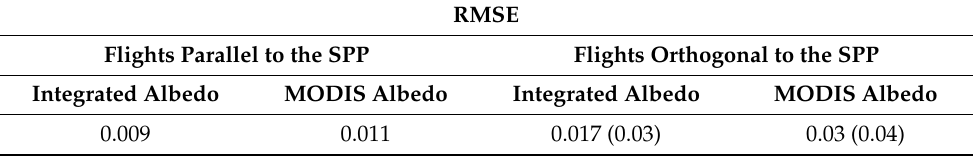
Figure 12. Comparison between field-measured albedo and airborne albedo for flights parallel to the solar principal plane ( a ) and flights orthogonal to the solar principal plane ( b ). Blue solid circles and blue solid line correspond to the Integrated Albedo; the red solid circles and red line correspond to the MODIS Albedo. Table 6. RMSE values for the validation of airborne albedos for flights parallel to the solar principal plane (SPP) and orthogonal to the solar principal plane separately. For the Green Grass, the data for VZA = ´ 44.8 ˝ of the 9:38 UTC flight was discarded. The values in brackets are calculated taking the data into account.